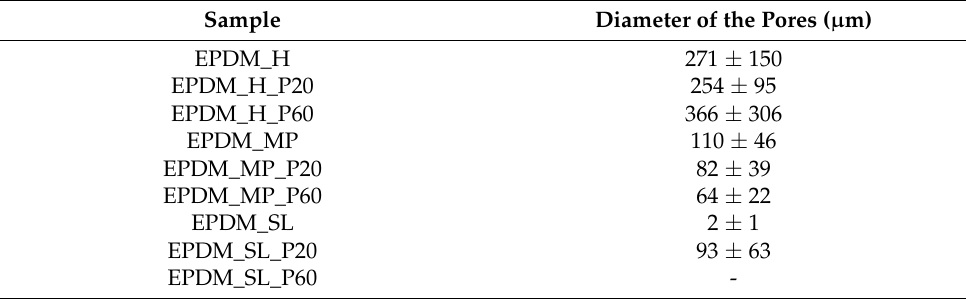
Figure 1. SEM micrographs at different magnification of the cryofracture surface of the prepared foams. ( a ) EPDM_H, ( b ) EPDM_MP, ( c ) EPDM_SL, ( d ) EPDM_H_P20, ( e ) EPDM_MP_P20, ( f ) EPDM_SL_P20, ( g ) EPDM_H_P60, ( h ) EPDM_MP_P60, ( i ) EPDM_SL_P60. The red arrow in Figure 1b indicates the microcapsules containing the physical blowing agent, while in Figure 1g the arrow shows the presence of a peculiar morphology. Table 4. Dimension of the pores of the produced foams.